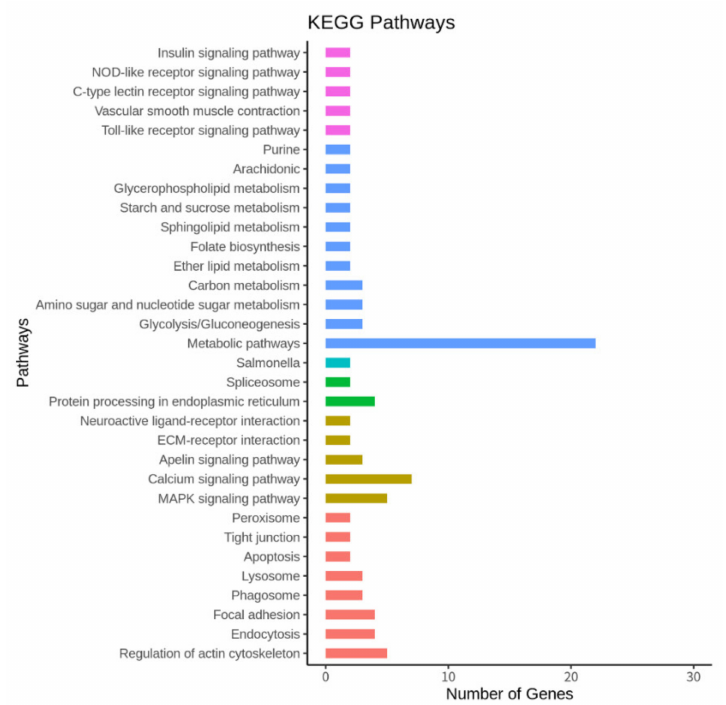
Figure 5. Enriched KEGG pathways of the DEGs ( p < 0.05) denoted by different colors for the various pathway types and by the number of